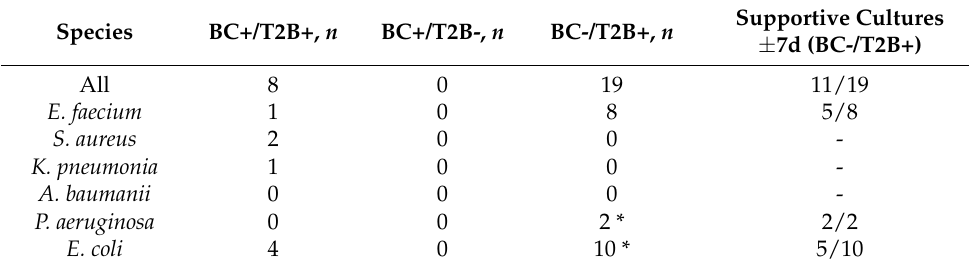
Table 2. Performance of T2Bacteria panel for on-panel bacterial species. Species BC+/T2B+, n BC+/T2B-, n BC-/T2B+, n